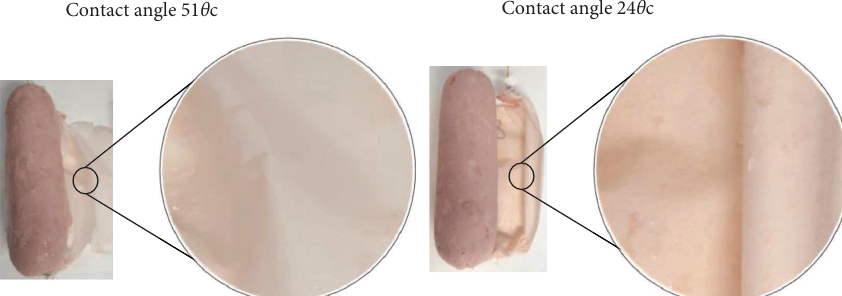
Figure 5: Comparison of meat emulsion adhesion to plastic casing with distinct surface tension. Both samples were stufed with meat emulsion recipe R 1 at 6% of overstufng.